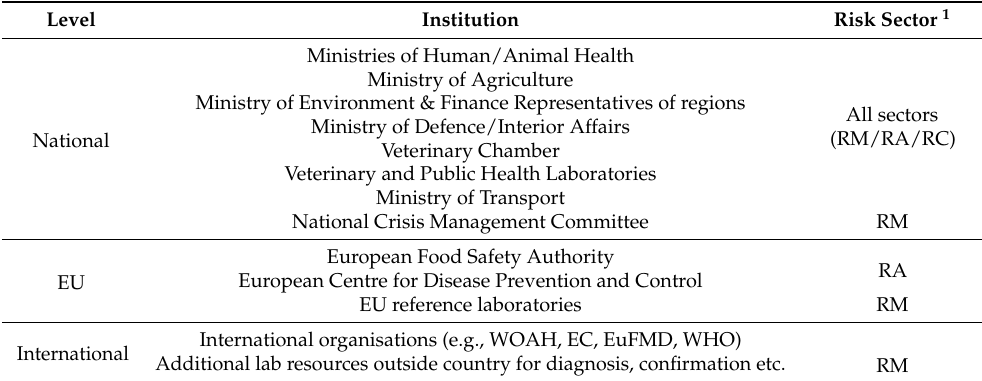
Table 1. Institutions and risk sectors to be represented in the National Crisis